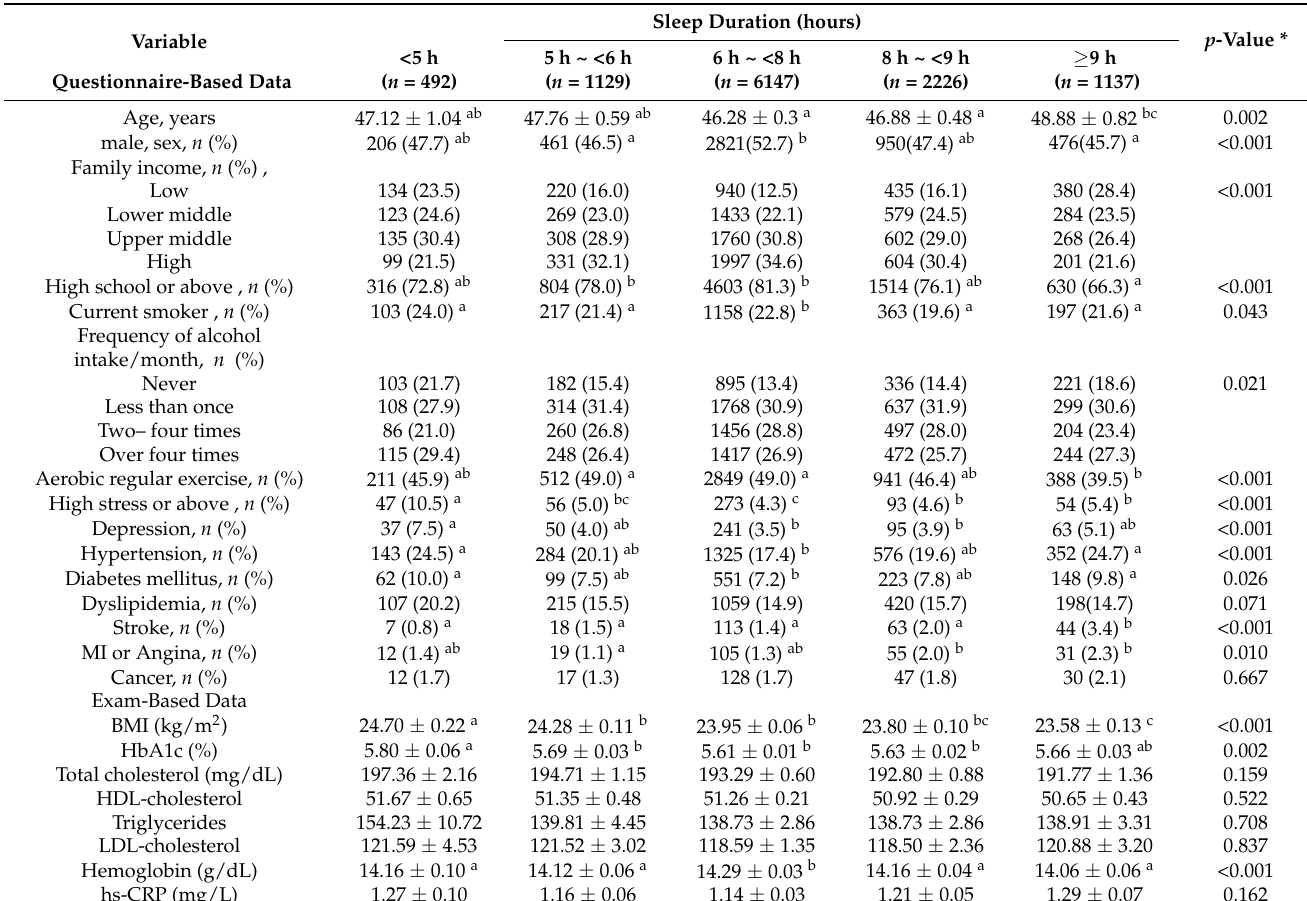
Table 1. Demographics of the study participants according to sleep duration.